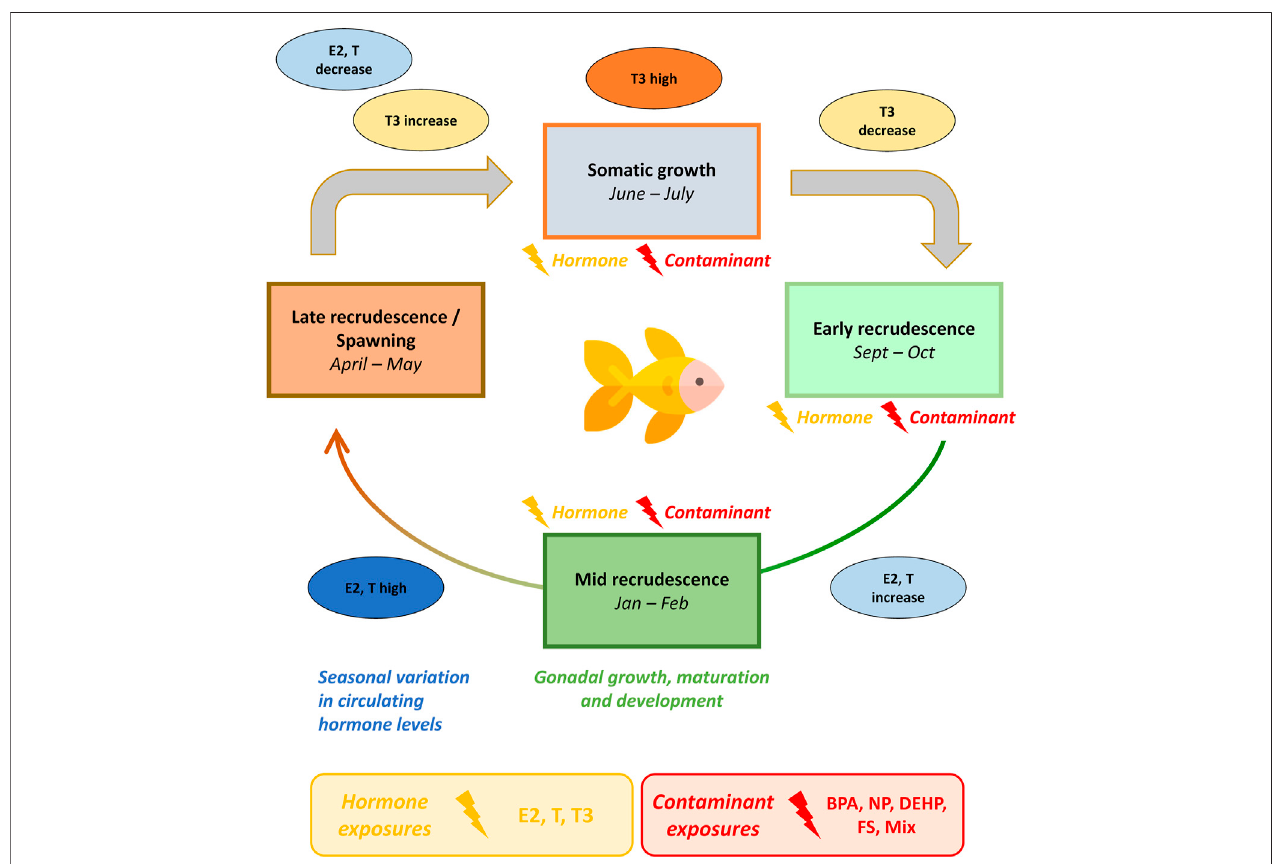
FIGURE 1 | Seasonal exposure model of male gold fi sh to hormone and contaminant treatments across growth and reproductive stages. Gold fi sh are seasonal breeders with an annual reproductive cycle. Gold fi sh gonad starts to grow and develop in fall (early recrudescence), reaching the mid-stage of development in winter (mid-recrudescence), the late stage in spring (late-recrudescence) and spawn in summer. Endogenous hormone levels and hormone receptor expression in gold fi sh exhibit seasonal variation. Circulating levels of sex steroid hormones (estrogens in females and androgens in males) are lowest during early stages of gonadal development, increase as the gonads develop and reach maximum concentration before spawning. Thyroid hormone levels are high during somatic growth stages and decrease during early recrudescence. In this seasonal exposure model, male gold fi sh were exposed to hormones or contaminants during October (early- recrudescence), February (mid-recrudescence) and June (late-recrudescence). Abbreviations: BPA, Bisphenol A; NP, nonylphenol; DEHP, bis(2-ethylhexyl) phthalate, fucosterol; and a tertiary mixture (DEHP + NP+ FS); T, Testosterone; E2, 17 β -estradiol; T3, Thyroid hormone (3,3 ′ ,5 ′ -Triiodo-L-thyronine). The gold fi sh icon used in this fi gure was made by Freepik (www.freepik.com) from www. fl aticon.com.